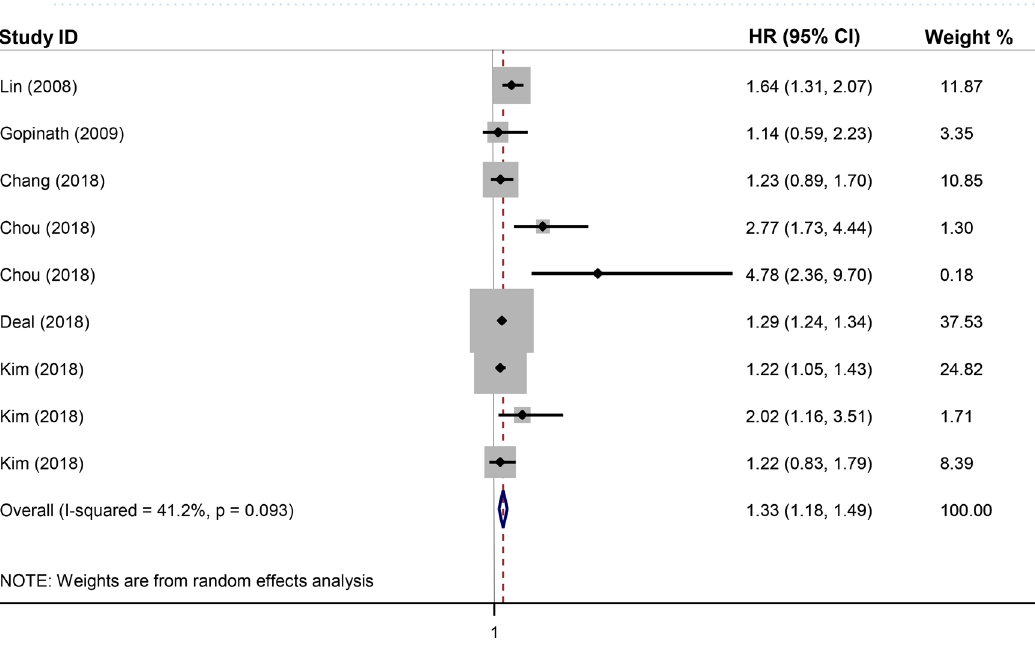
Figure 3. Forest plot for the association between sensorineural hearing loss (SNHL) and the incidence of stroke in the adjusted model. HR adjusted hazard ratio, CI confidence